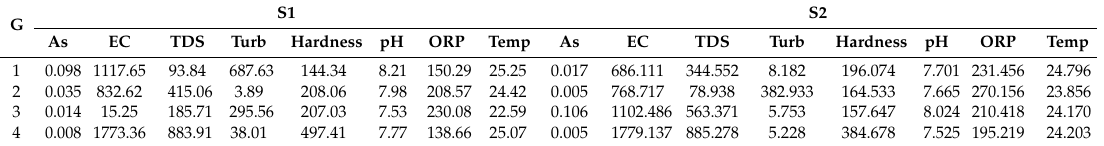
Table 6. Average value of the PhP by groups.